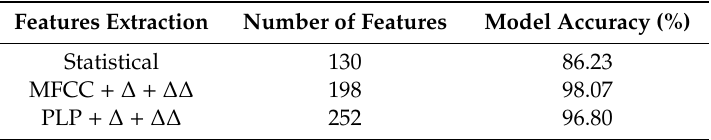
Table 4. An overall result of test dataset.